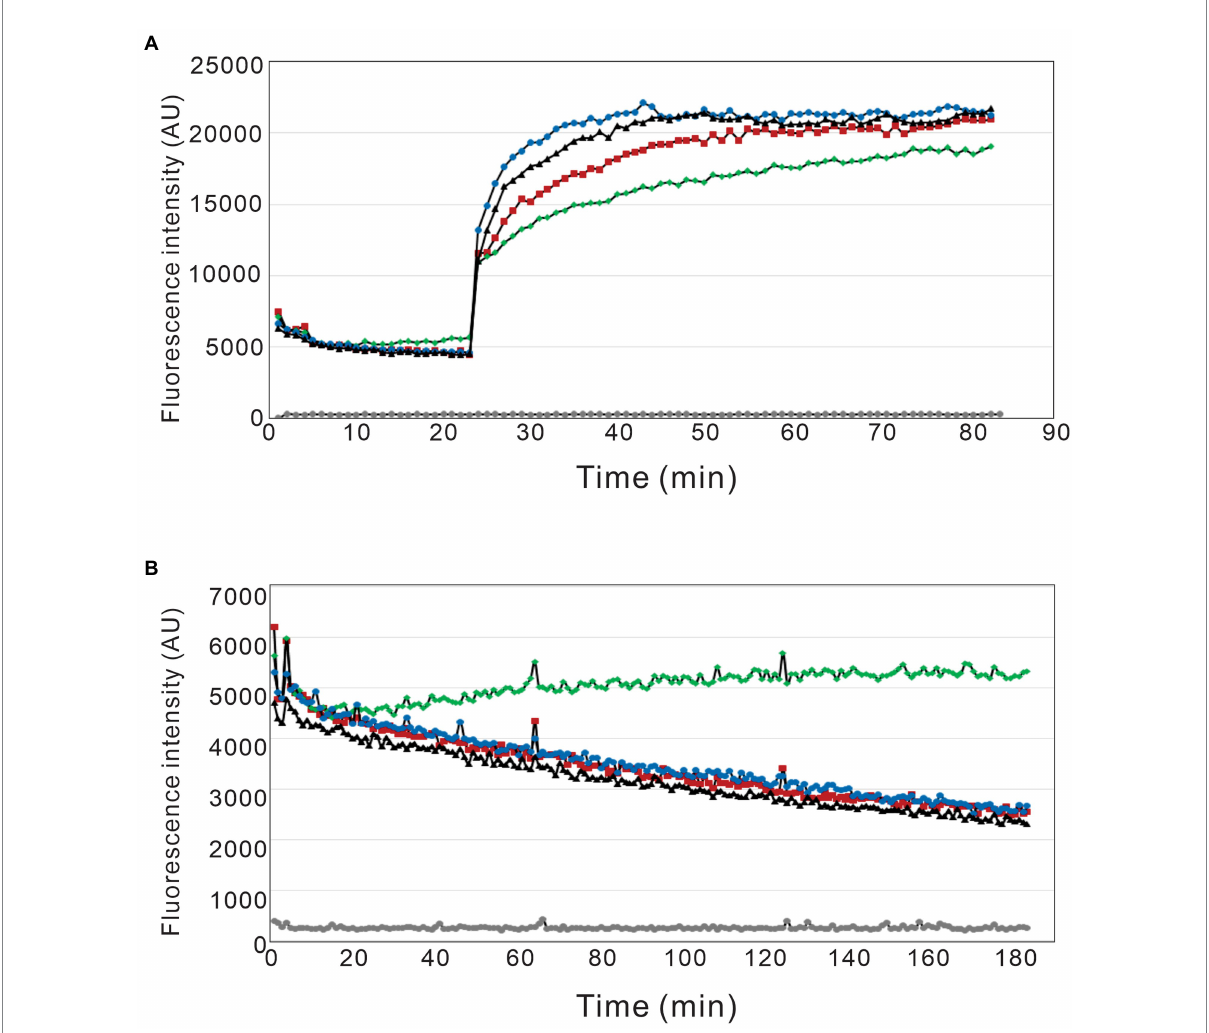
FIGURE 7 Pyrene labeled actin polymerization and depolymerization assay. The effect of phalloidin, native occidiofungin, and the DL-dihydrosphingosine analog on actin (A) polymerization and (B) depolymerization assays. (grey ● ) represents buffer baseline control; (red ■ ) represents no drug control; (green ◆ ) represents phalloidin treatment; (blue ● ) represents native occidiofungin treatment; (black ▲ ) represents DL-dihydrosphingosine analog treatment. The fluorescent data is measured in terms of arbitrary units